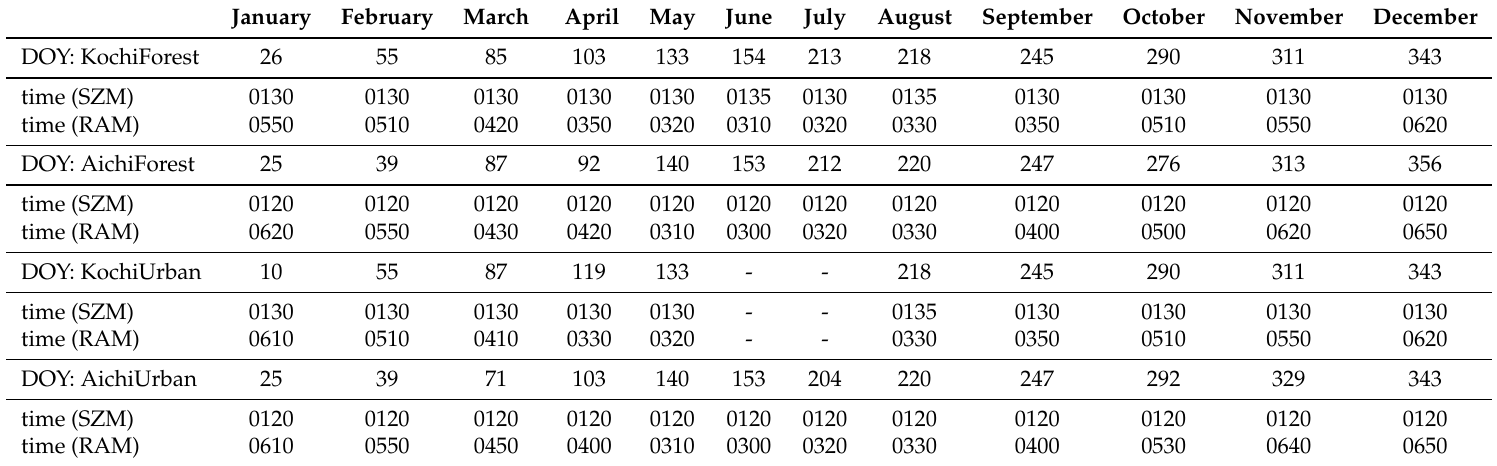
Table 4. UTC time and DOY for the selected AHI data in the SZM and RAM